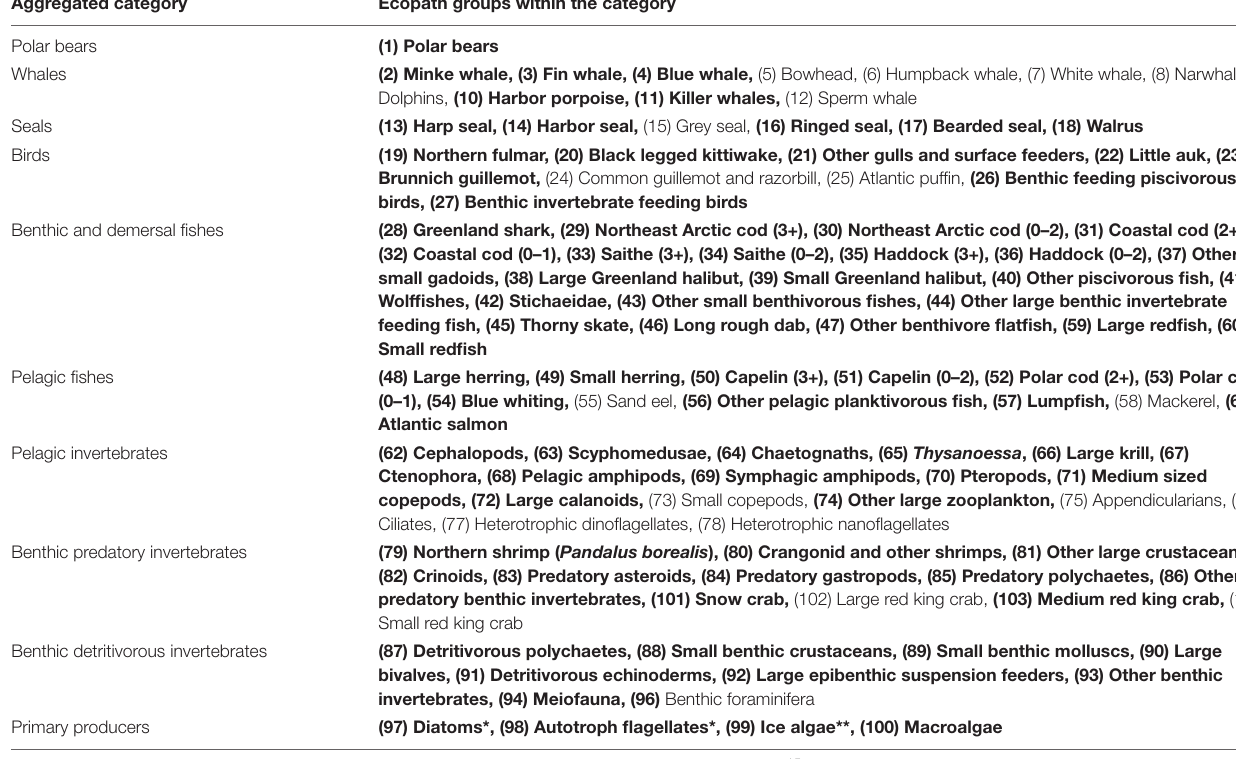
TABLE 2 | Overview of functional groups for which output values from Ecopath were aggregated into major categories. Aggregated